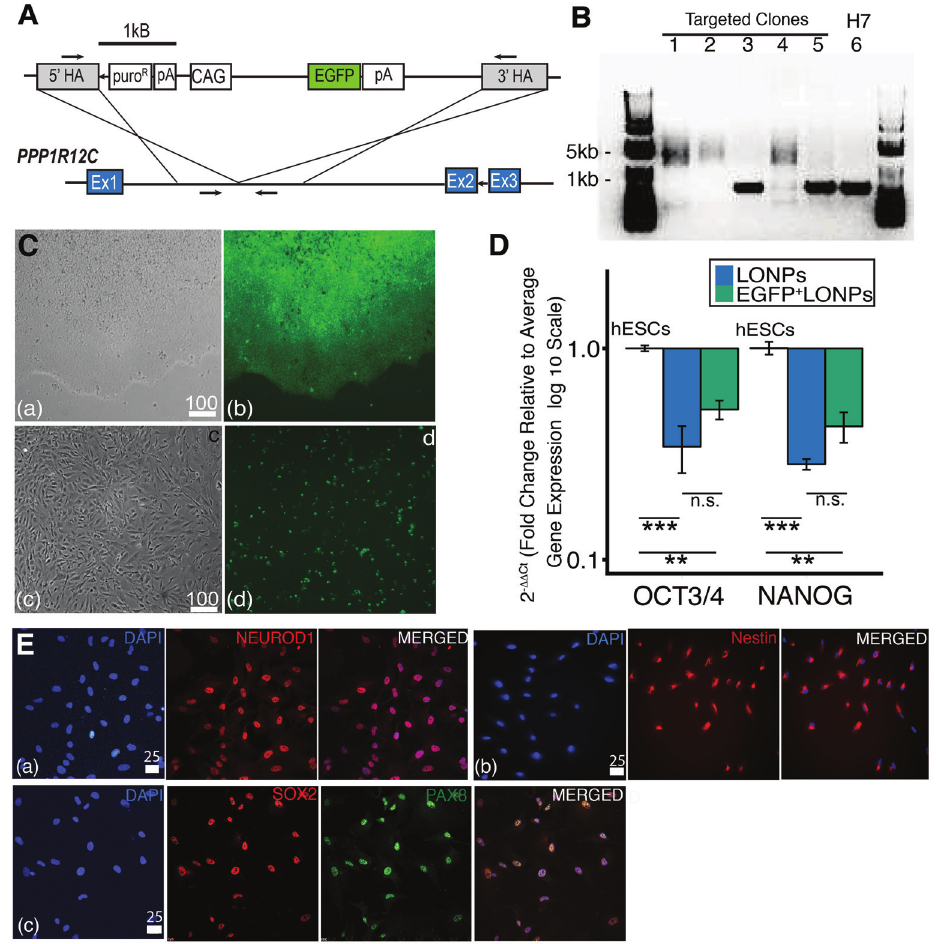
Fig 4. CRISPR-Cas9-modified EGFP + hESCs that differentiated towards late-stage ONP lineage possess late-stage otic neuronal progenitor characteristics. (A) : Schematic of AAVS1 safe harbor locus within PPP1R12Cgene and targeting vector containing puromycin-resistancecassette (puro ® ), CAG enhancer, and EGFP within 5’ and 3’ homology arms (HA). Arrows indicate PCR primers. (B) : EGFP targeting was validatedby PCR. H7: H7 human ESCs were used as a control (untargetedclone). ( C ): CRISPR-Cas9 modifiedEGFP + undifferentiated hESCs in culture. (Ca) : phasecontrast, (Cb) : fluorescence (EGFP + ) imaging. CRISPR-CAs9 modifiedEGFP + late-stage ONPs: (Cc) : phase contrast, (Cd) : fluorescence imaging. Scale bar = 100 μ m. ( D ): RT-PCR quantification of OCT3/4 and NANOG expressionmeasurements for H7 hESC, H7 late-stage ONPs (lONPs), and CRISPR-Cas9 modified EGFP + late-stage ONPs. n.s.: not statistically significant, *** p < 0.001, and ** p < 0.01 by one-way ANOVA with Tukey-Kramer’s post-hoc test. (E) : Immunocytochemistry of CRISPR-Cas9 modifiedEGFP + late-stage ONPs for NEUROD1 (Ea) , nestin (Eb) , SOX2, and PAX8 (Ec) . Scale bar = 25 μ